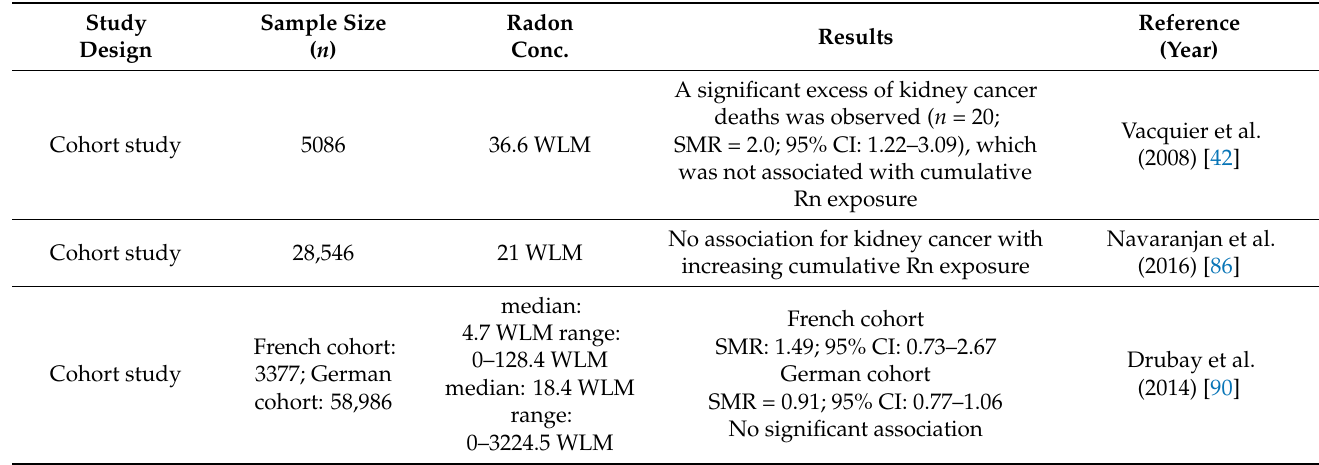
Table 5. Kidney cancer: